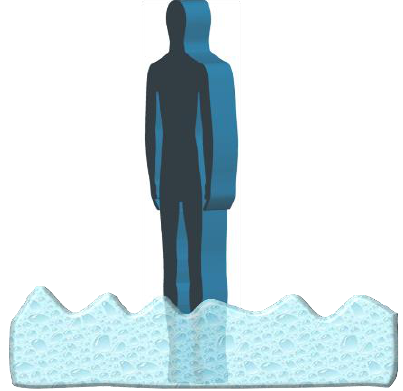
Figure 18. A sketch of a model of a man in a flood.